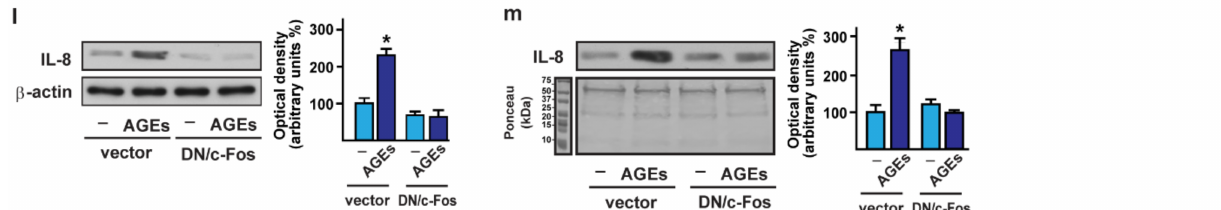
Figure 3. c-Fos is involved in the upregulation of IL-8 induced by AGEs/RAGE signaling in CAFs. ( a ) Luciferase activities of IL-8 promoter construct in CAFs treated for 18 h with vehicle or 100 µ g/mL AGEs in the presence or absence of 1 µ M RAGE inhibitor FPS-ZM1, 300 µ M free radical scavenger NAC, 100 nM MEK inhibitor trametinib or 1 µ M PI3K inhibitor alpelisib, as indicated; ( b ) Luciferase activities of c-Fos promoter construct in CAFs upon exposure for 18 h to vehicle or 100 µ g/mL AGEs alone and in combination with 1 µ M RAGE inhibitor FPS-ZM1, 300 µ M free radical scavenger NAC, 100 nM MEK inhibitor trametinib or 1 µ M PI3K inhibitor alpelisib, as indicated. The luciferase activities were normalized to the internal transfection control, and values of cells receiving vehicle were set as 1-fold induction upon which the activity induced by AGEs was calculated. Each column represents the mean ± SD of three independent experiments performed in triplicate. mRNA ( c , f ) and protein ( d , g ) expression of c-Fos evaluated, respectively, by real-time PCR and immunoblotting in CAFs treated for 4 h with vehicle (–) or 100 µ g/mL AGEs alone and in the presence of 1 µ M RAGE inhibitor FPS-ZM1 or in combination with 300 µ M free radical scavenger NAC. In RNA experiments, values were normalized to the beta-actin (ACTB) expression and shown as fold changes of c-Fos mRNA expression upon AGEs treatment compared to cells exposed to vehicle; ( e ) Immunoblots showing c-Fos protein expression in CAFs transfected with non-targeting scramble siRNA or siRAGE (10 nM) for 24 h and then exposed for 4 h with vehicle (–) or 100 µ g/mL AGEs; ( h ) c-Fos protein expression evaluated by immunoblotting in CAFs treated for 4 h with vehicle (–) or 100 µ g/mL AGEs alone and in combination with 100 nM MEK inhibitor trametinib or 1 µ M PI3K inhibitor alpelisib; ( i , j ) Recruitment of c-Fos to the AP-1 site located within the IL-8 promoter region upon treatment for 4 h with AGEs in CAFs, as assessed by Chromatin Immunoprecipitation (ChIP) assays. Data obtained were normalized to the input and shown as fold changes in relation to nonspecific Immunoglobulin G (IgG). Each column represents the mean ± SD of three independent experiments performed in triplicate; ( k ) Luciferase activities of IL-8 promoter construct in CAFs transfected for 18 h with an empty vector or a plasmid encoding for a dominant negative form of c-Fos (DN/c-Fos) and then exposed for 18 h to vehicle or 100 µ g/mL AGEs. The luciferase activities were normalized to the internal transfection control and values of cells receiving vehicle were set as 1-fold induction upon which the activity induced by treatment was calculated. Each column represents the mean ± SD of three independent experiments performed in triplicate; ( l ) IL-8 protein expression evaluated by immunoblotting in CAFs transfected with the empty vector or with the DN/c-Fos construct for 18 h and then treated with vehicle (–) or 100 µ g/mL AGEs for 8 h. β -actin served as a loading control; ( m ) Immunoblotting of IL-8 in conditioned medium (CM) collected from CAFs transfected with a vector or with the DN/c-Fos construct and then treated for 8 h with vehicle (–) or 100 µ g/mL AGEs. Ponceau red staining of the membrane was used as a loading control for the CM. Side panels show densitometric analysis of the blots normalized to the loading controls. Data shown represent the mean ± SD of three independent experiments. (*) indicates p <